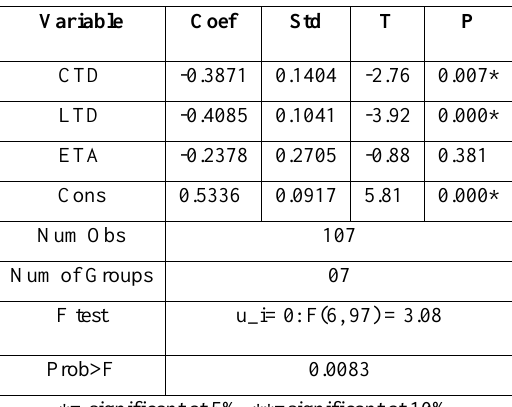
Table 4: Fixed-Effects results